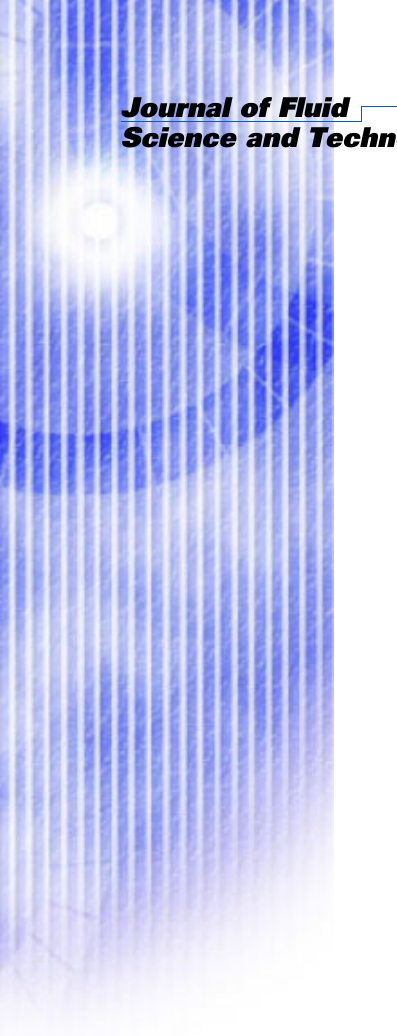
Fig. 9 Ensemble-averaged time histories of conditionally sampled velocity and wall static pressure at lower modes ( n = 1 ∼ 3) corresponding to the bulge structure